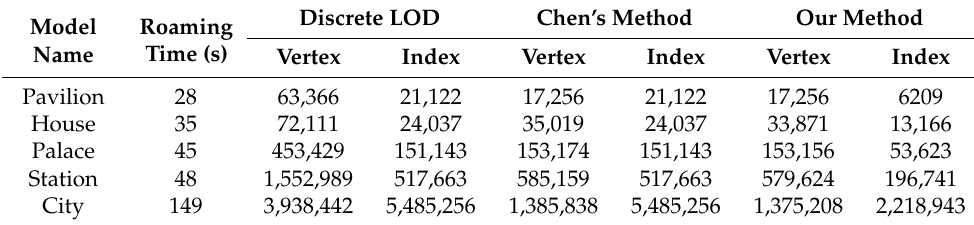
Table 2. Comparison of the cumulative transmitted data volume.